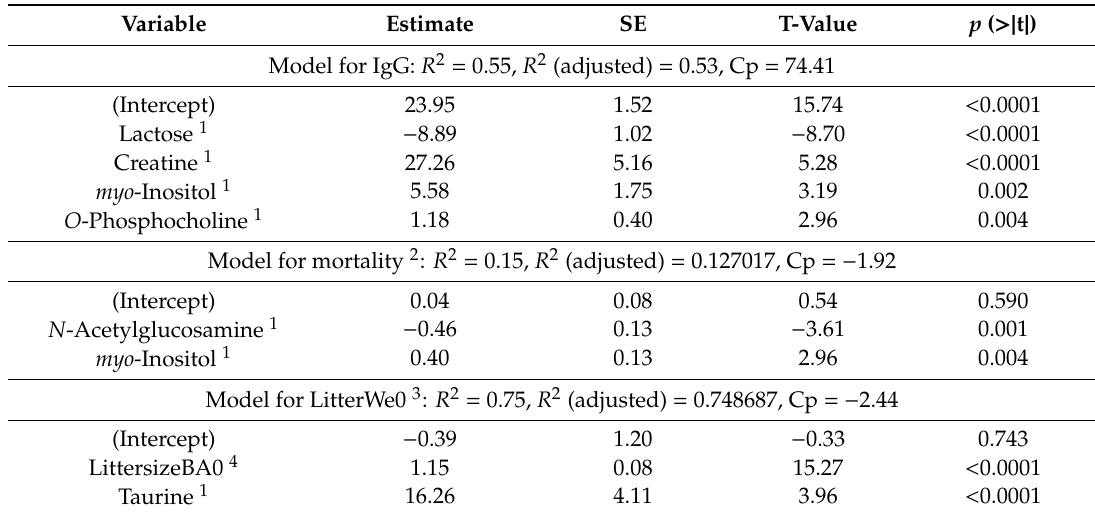
Table 6. Results of stepwise analysis on sows’ productive traits.